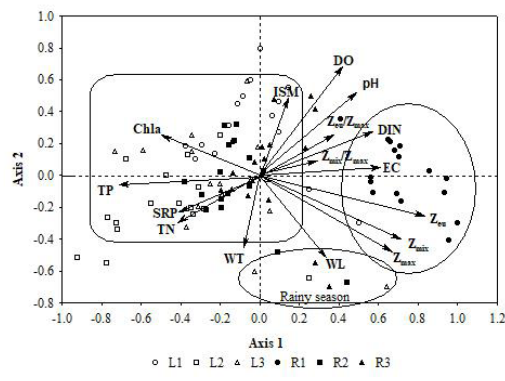
Figure 4. First two axes generated by Principal Component Analysis (PCA) on the studied environments. Water level (WL), Water temperature (WT), Soluble reactive ) phosphorus (SRP), Total nitrogen (TN), Dissolved max inorganic nitrogen (DIN), Dissolved oxygen (DO), Electrical conductivity (EC), Chlorophyll a (Chla), Inorganic soluble material (ISM), Mixture zone (Zmix), Euphotic zone (Zeu), Depth